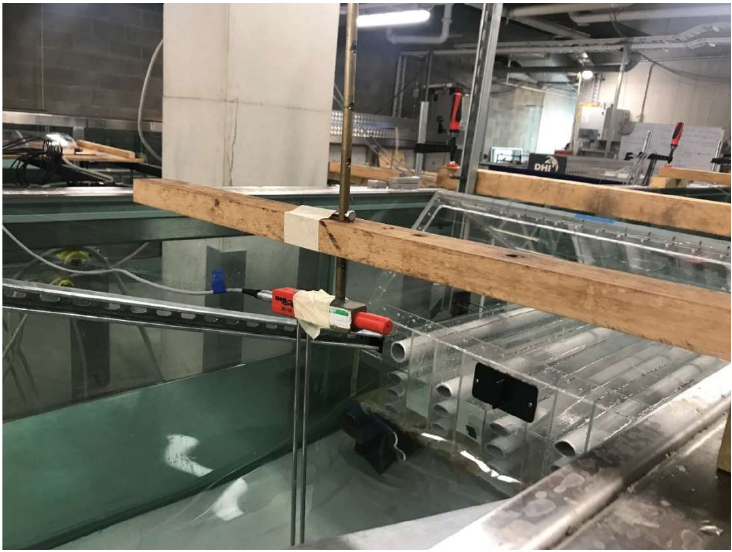
Table 2. Model Test Parameters.